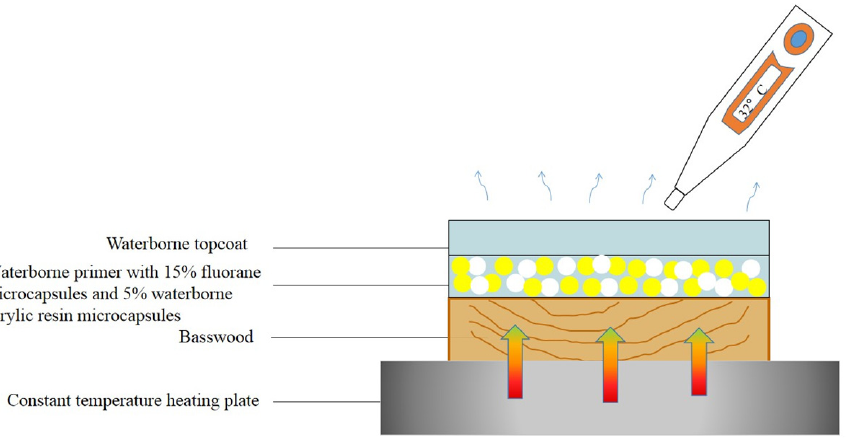
Figure 11. Schematic diagram of the thermochromic mechanism of fluorane with the synergistic effect of waterborne acrylic microcapsules.